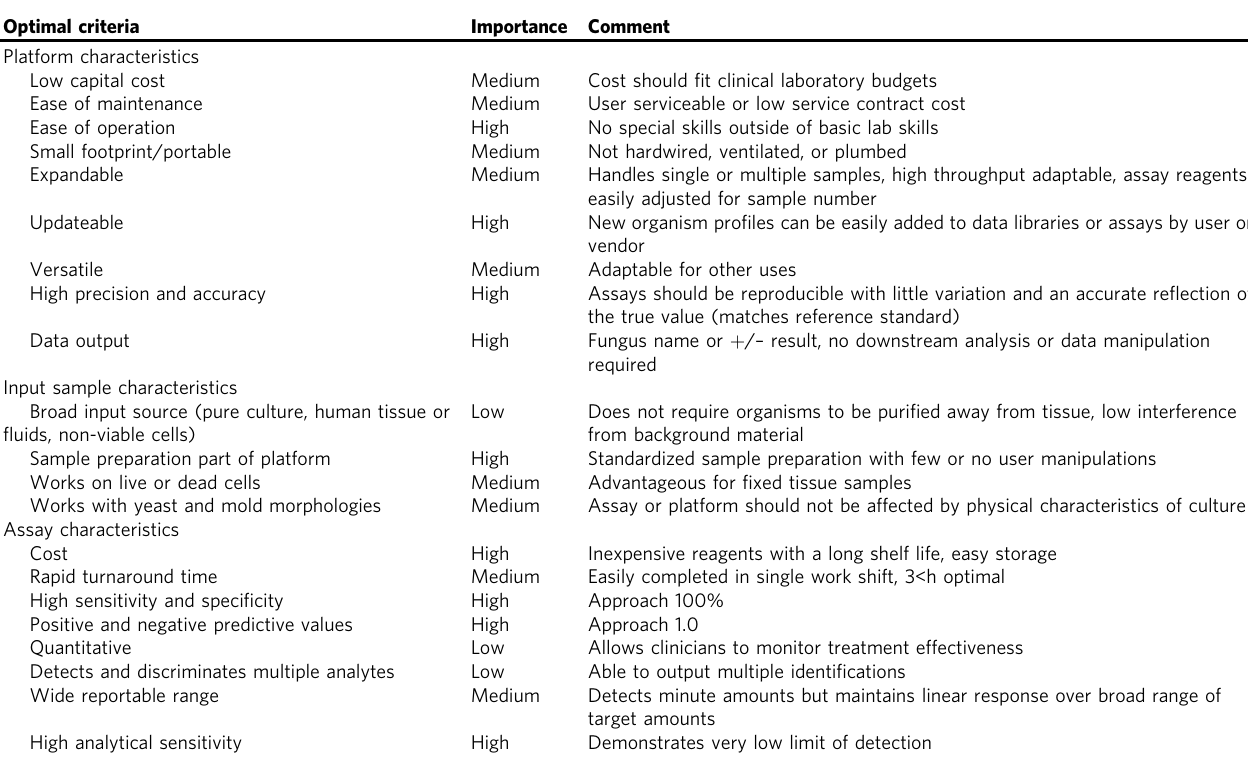
Table 1 Preferred characteristics of new diagnostic